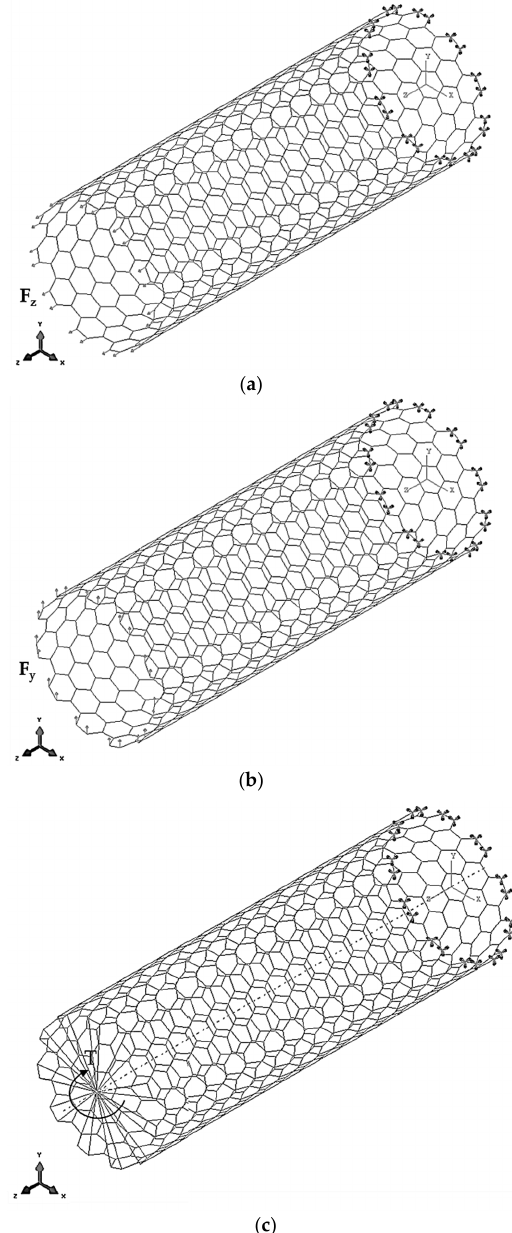
Figure 6. Boundary and loading conditions for testing (11, 11) armchair SWInNNTs of: ( a ) Tension; ( b ) Bending; ( c ) Torsion.